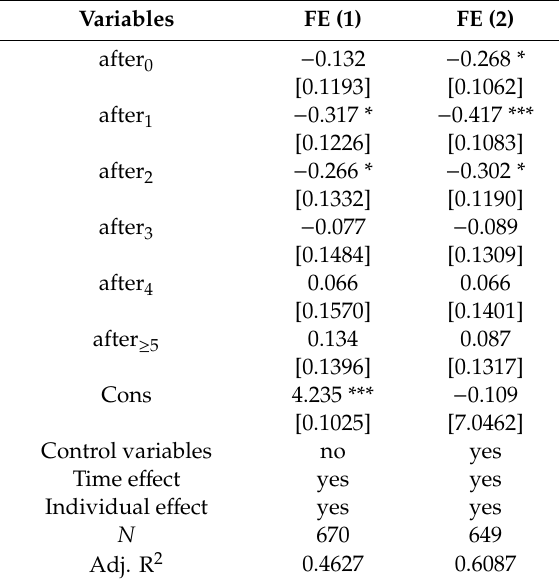
Table 5. Test of the dynamic e ff ects of HSR